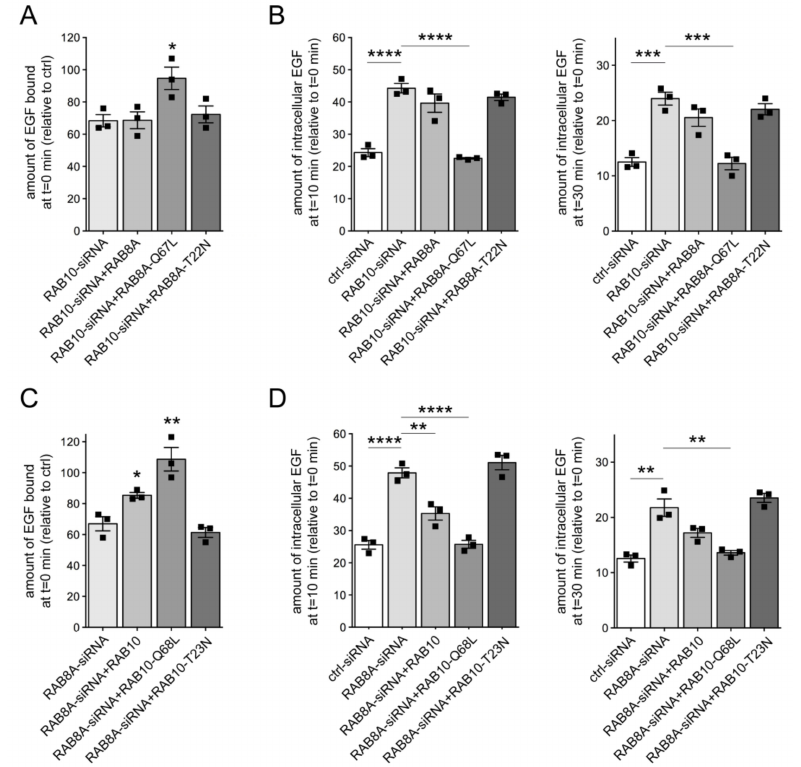
Figure 4. RAB8A and RAB10 are functionally redundant in regulating endolysosomal EGF tra ffi cking. ( A ) HeLa cells were either transfected with ctrl-siRNA or RAB10-siRNA, and co-transfected with GFP-tagged RAB8A constructs as indicated, and the amount of surface-bound fluorescent EGF was quantified. N = 3 independent experiments; * p < 0.05. ( B ) Cells were transfected with ctrl-siRNA or RAB10-siRNA, and co-transfected with GFP-tagged RAB8A constructs as indicated, and internalized fluorescent EGF was quantified at 10 min (left) and 30 min (right). N = 3 independent experiments; *** p < 0.005; **** p < 0.001. ( C ) HeLa cells were either transfected with ctrl-siRNA or RAB8A-siRNA, and co-transfected with GFP-tagged RAB10 constructs as indicated, and the amount of surface-bound fluorescent EGF was quantified. N = 3 independent experiments; * p < 0.05; ** p < 0.01. ( D ) Cells were transfected with ctrl-siRNA or RAB8A-siRNA, and co-transfected with GFP-tagged RAB10 constructs as indicated, and internalized fluorescent EGF was quantified at 10 min (left) and 30 min (right). N = 3 independent experiments; ** p < 0.01; **** p <